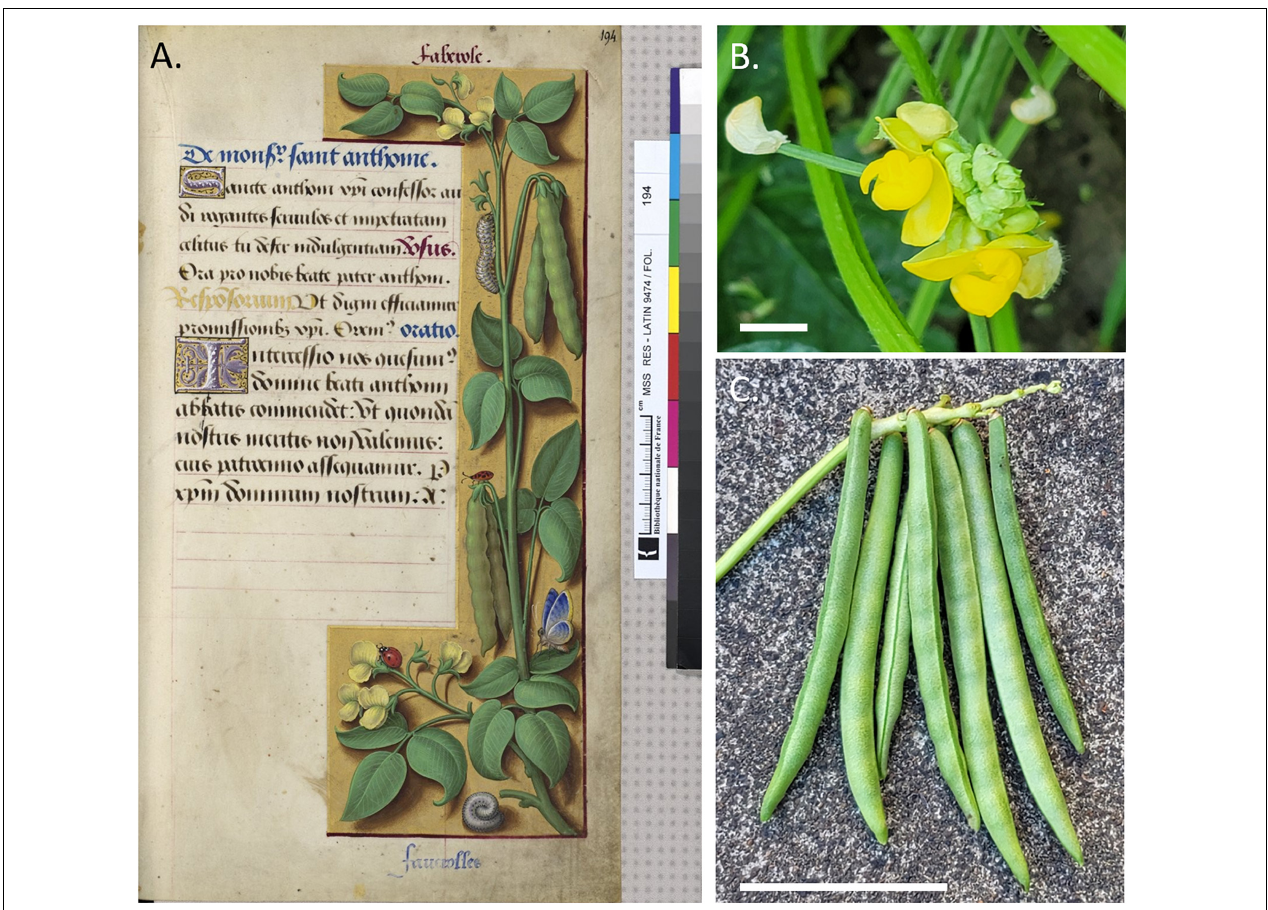
FIGURE 1 | Image from the Grandes Heures d’Anne de Bretagne of a putative illustration of common bean and the possible species the image actually represents. (A) Digitized image of Folio 194 from Ms. Latin 9474 at the Bibliothèque Nationale de France. (B) Adzuki bean ( Vigna angularis ), representative of the subgenus Ceratotropis - flowers (size bar = 1 cm) and (C) Raceme with green pods (size bar = 5 cm). Photos: J. R. Myers.